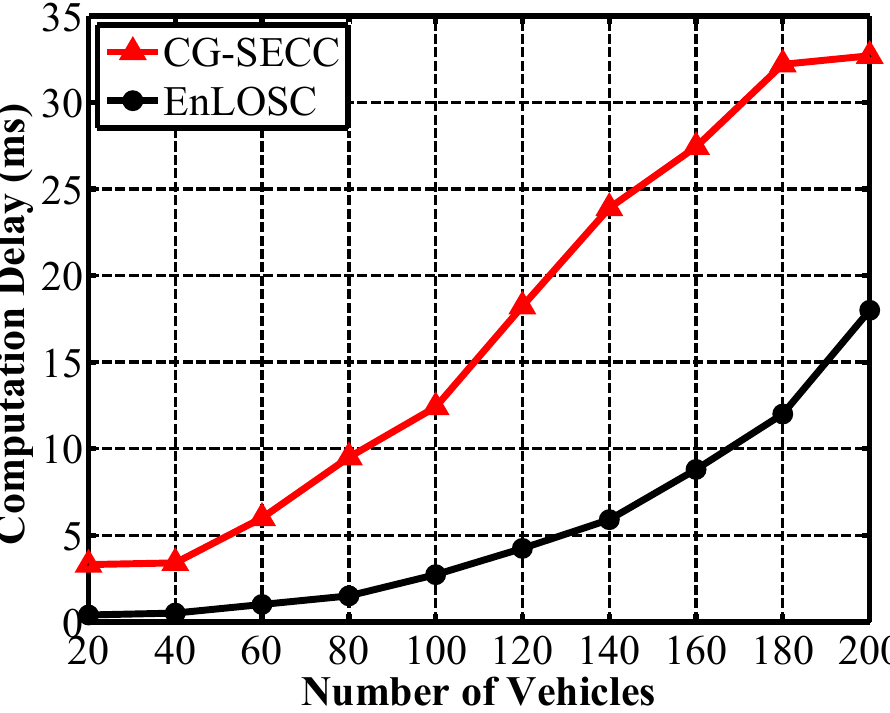
Figure 7. Analysis of calculated delay for clustering formation.